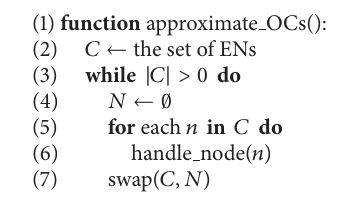
Algorithm 1: A function for going through a tech tree appropri- ately. Executing this results in having OC estimates for each node, as well as estimated optimal ancestor sets and optimal ABIs.